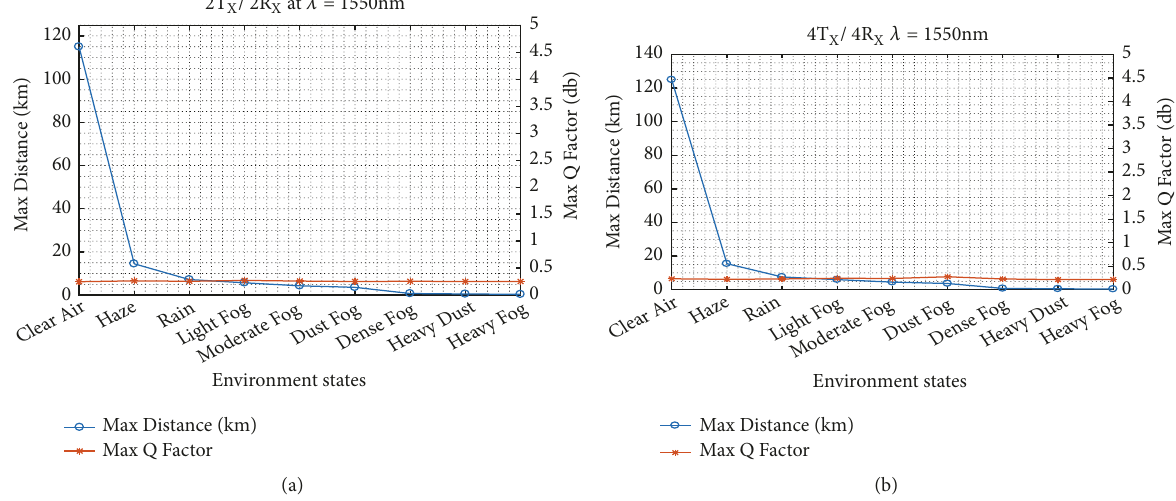
Figure 6: Relation between max distance (km) and attenuation (db/km) at wavelength=1550nm. (a) Using 2T X /2R X ; (b) using 4T X /4R X .